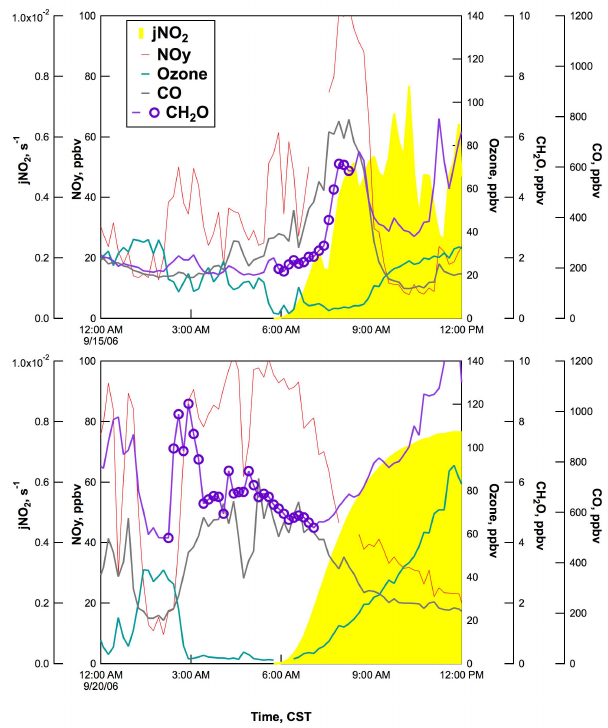
Fig. 6. Time series observed during the mornings of 15 and 20 September 2006 at Moody Tower in the same format as Fig. 5. Small circles indicate the CH 2 O data for those days included in the linear regressions illustrated in Fig.